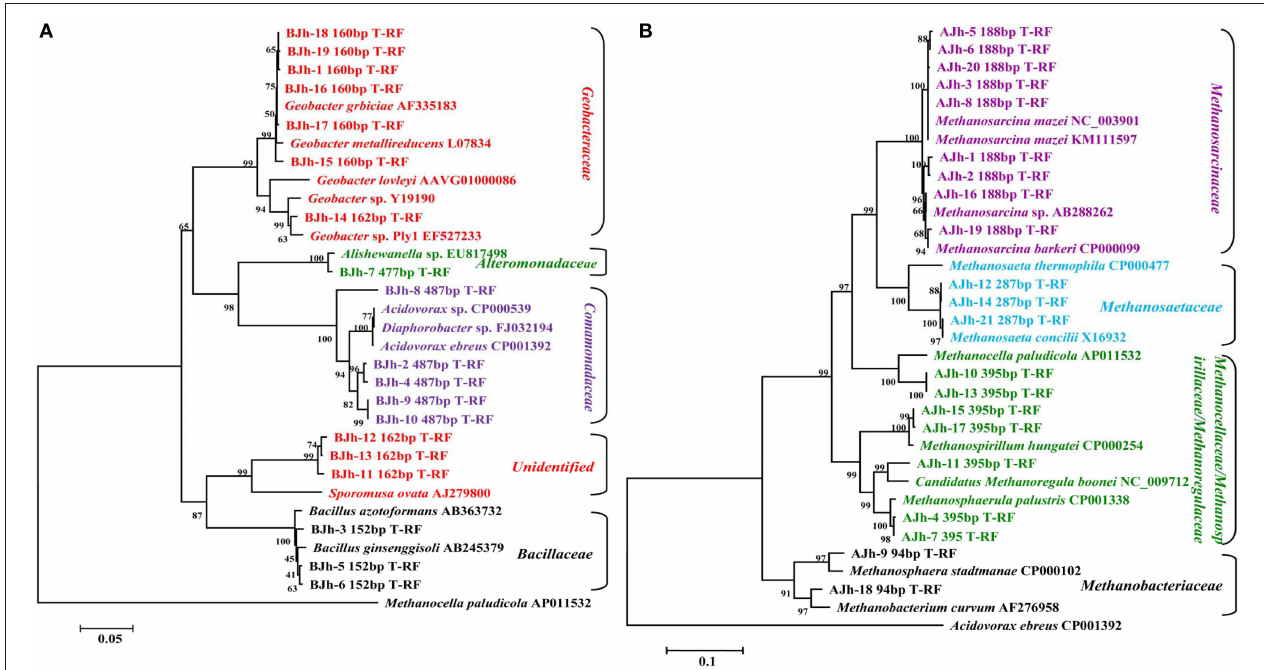
FIGURE 5 | Neighbor-joining phylogenetic tree of representative bacterial (A) and archaeal (B) 16S rRNA gene clones generated from DNA and RNA extracted from in situ sediments and enrichment cultures. Numbers of T-RF lengths are shown in base pairs. An association with the sequence of the highest similarity in the database and GenBank accession number of reference sequence as indicated. The scale bars represents 5% (A) and 10% (B) sequence divergence, respectively. Methanocella paludicola and Acidovorax ebreus were selected as outgroups of bacterial (A) and archaeal (B) phylogenetic tree, respectively.